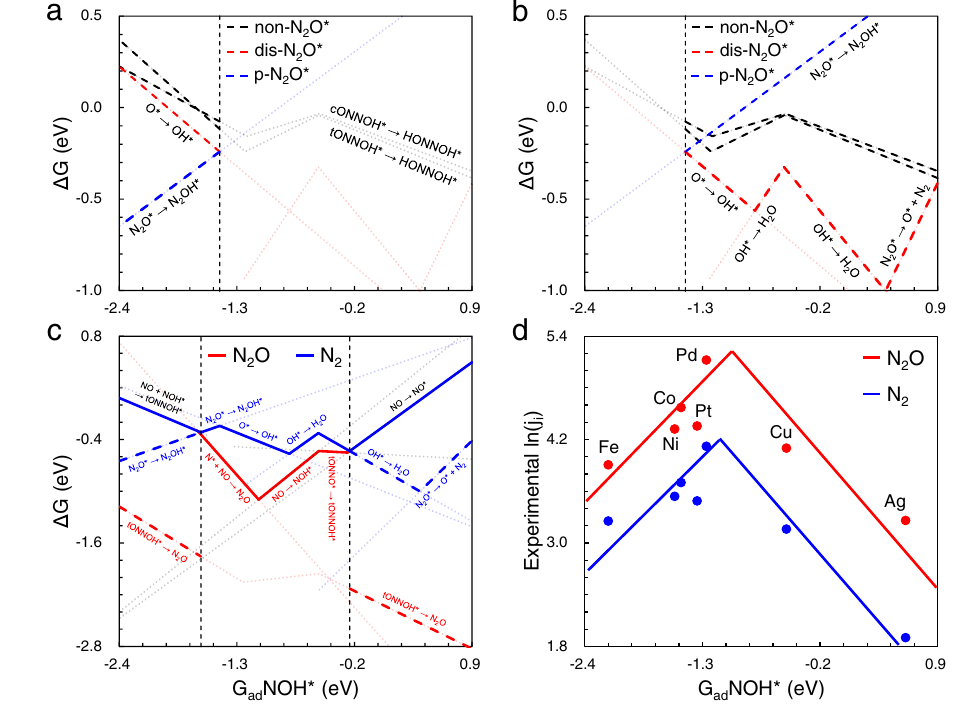
Fig. 5 | The one-dimensional reaction phase diagrams (1D-RPDs) and activity trend forN 2 andN 2 Oproductionsat0V vs. RHE.a , b Thepathpreferenceof( a ) p-N 2 O*(blue)onstronglyreactiveTMs(G ad NOH*< − 1.46eV)and( b )dis-N 2 O*(red) over others with G ad NOH* from − 1.46 to 0.9eV, compared to non-N 2 O* path (black), where the selective key steps are marked explicitly. c The selectivity